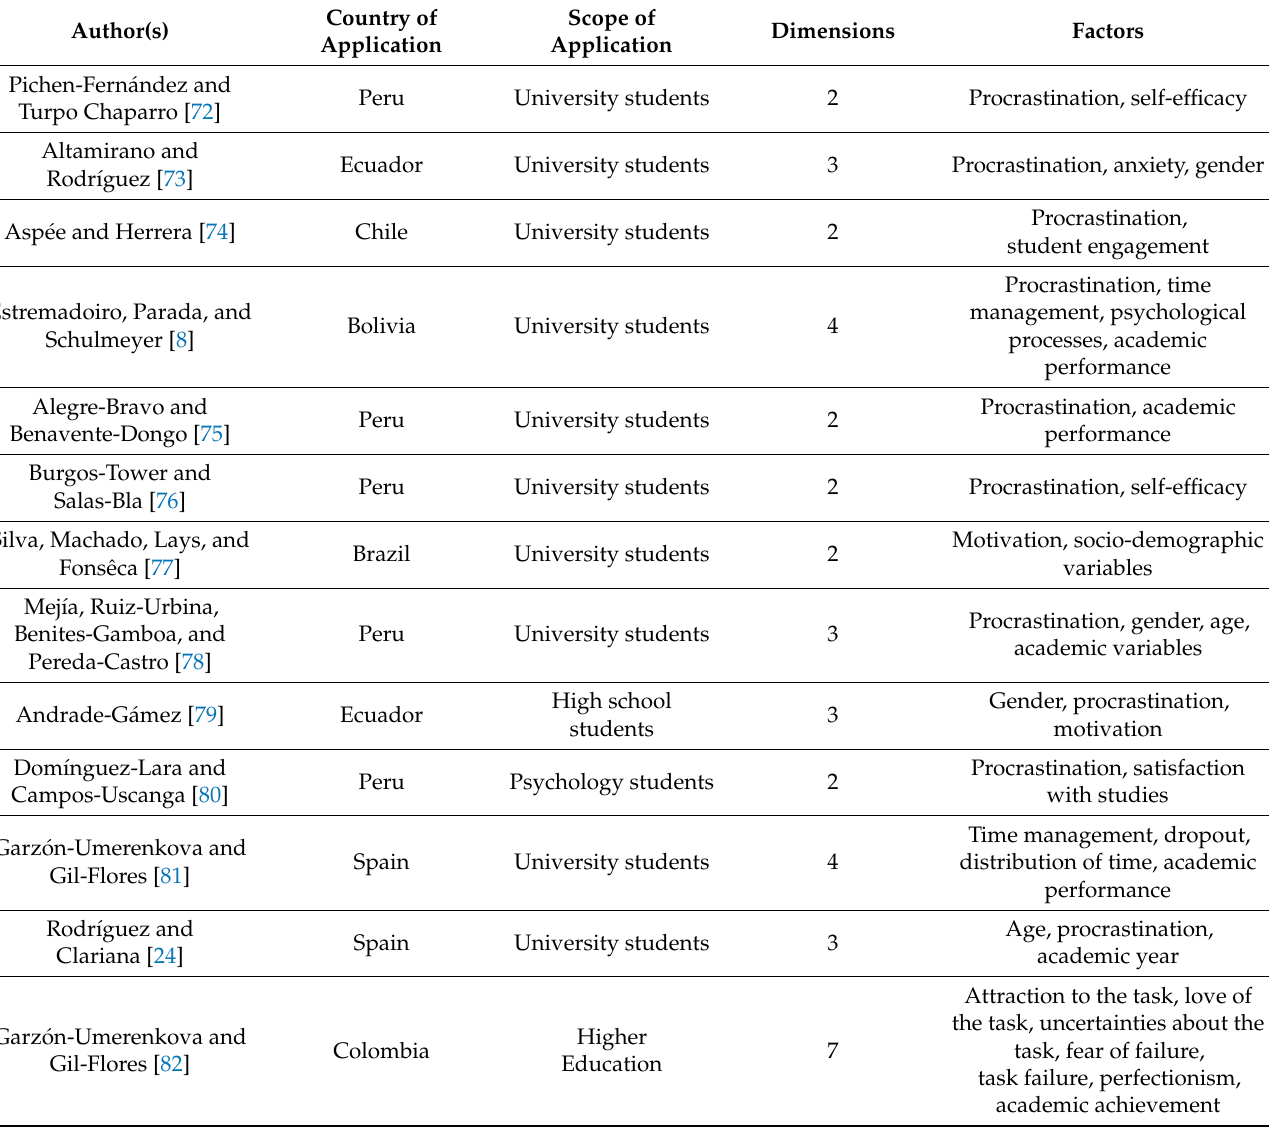
Table 1. Previous Scales on